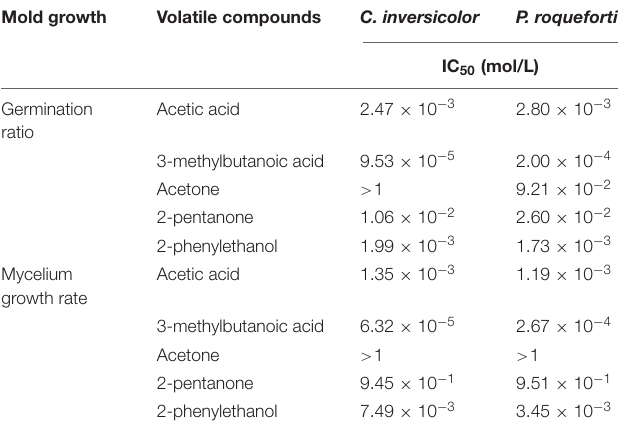
TABLE 5 | IC 50 of different VOCs for inhibiting germination and mycelium growth of P. roqueforti and C. inversicolor . Mold